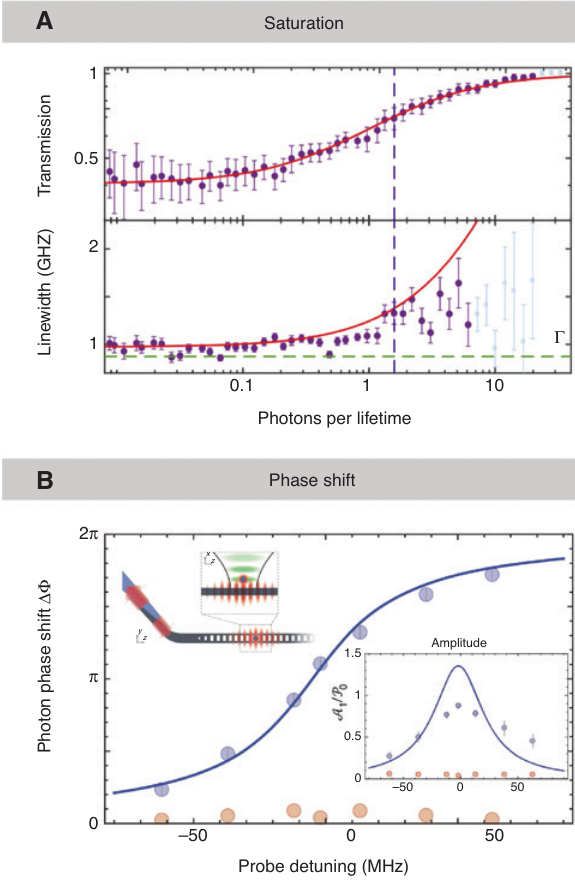
Figure 3: Nonlinear dependence of Δ T and the presence of a TLS fundamentally changes the response of a nanophotonic system. (A) The coherent nonlinear response of a TLS is seen in the power- dependent extinction of the transmitted light, which vanishes as the photon flux increases beyond one photon per lifetime (top panel). As the same time, the bandwidth of the transition begins to power-broaden (bottom panel), signifying the loss of coherence in the light-matter interactions. Adapted from [64]. (B) An efficiently coupled TLS, here an atom evanescently coupled to a photonic crystal cavity (top inset), can also modulate the phase of the scattered photons. In fact, markedly different responses are seen in the presence of the emitter (blue symbols) and in its absence (yellow symbols). The bottom inset shows the corresponding normalized count rate in one arm of an interferometer, relative to the expected cavity response (blue curve). Adapted from [67].